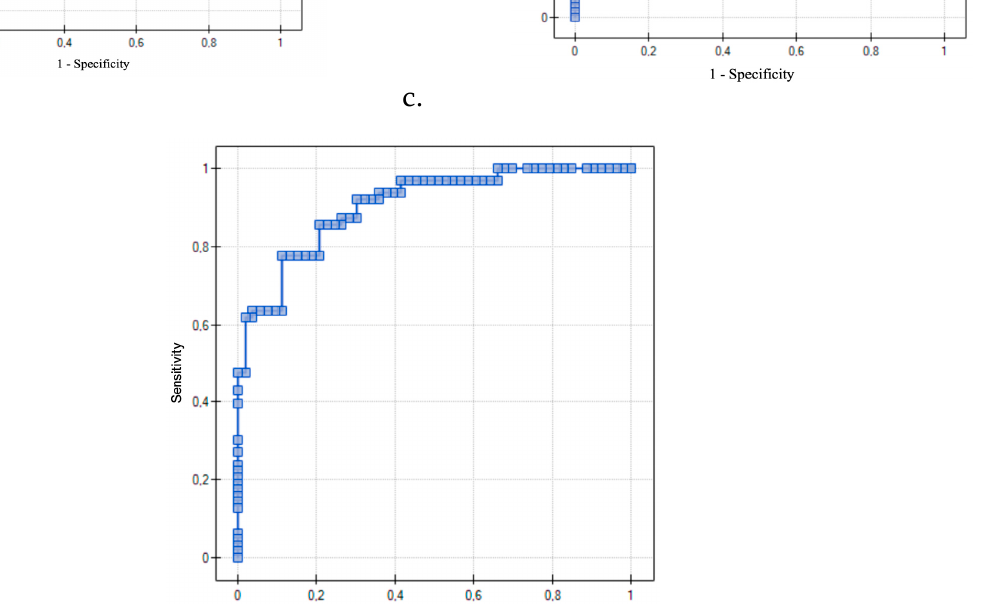
Table 7. The diagnostic values of IL-8 and TNF- α separately and combined in distinguishing be- tween malignant and benign ovarian lesions.